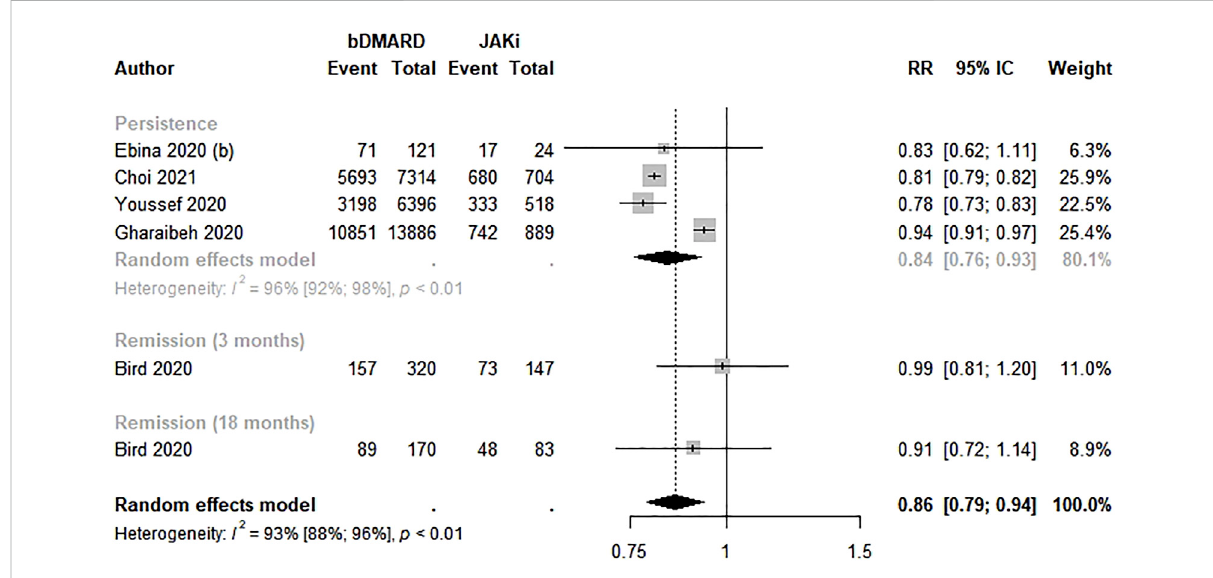
FIGURE 4 Effectiveness of biological disease-modifying anti-rheumatic drugs compared to Janus kinase inhibitors. bDMARD: biological disease- modifying anti-rheumatic drug; JAKi: Janus kinase